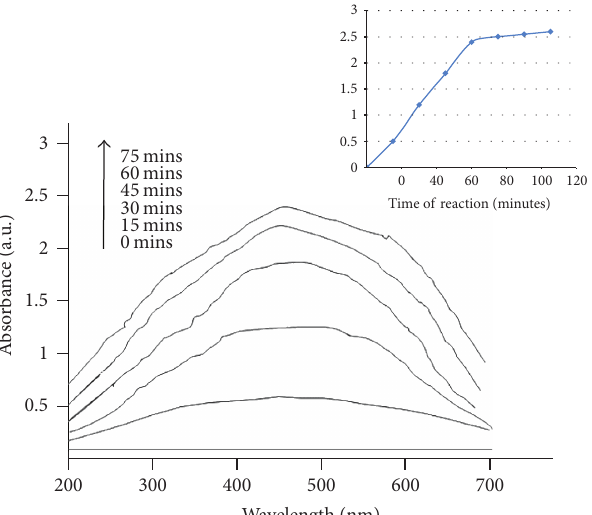
F 3: UV-Vis absorption spectrum of AgNPs recorded aer regular intervals. Inset shows the plot of absorbance at time.